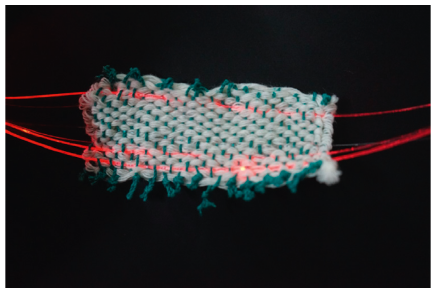
Figure 4: Light intensity measurement of a fiber inserted within plain weave